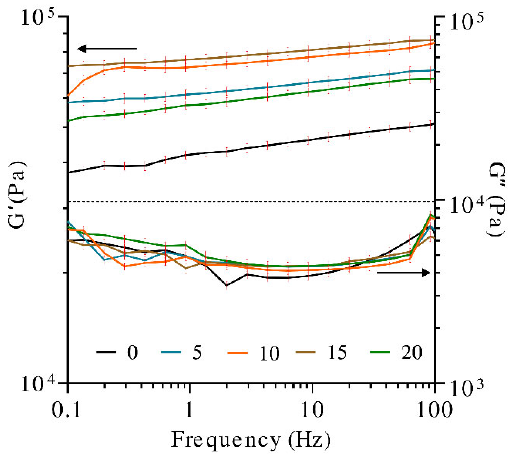
Figure 4. Dynamic frequency sweep tests (storage modulus (G ′ ) and loss modulus (G ″ ) in hydrogels at different exposure times to UV radiation).